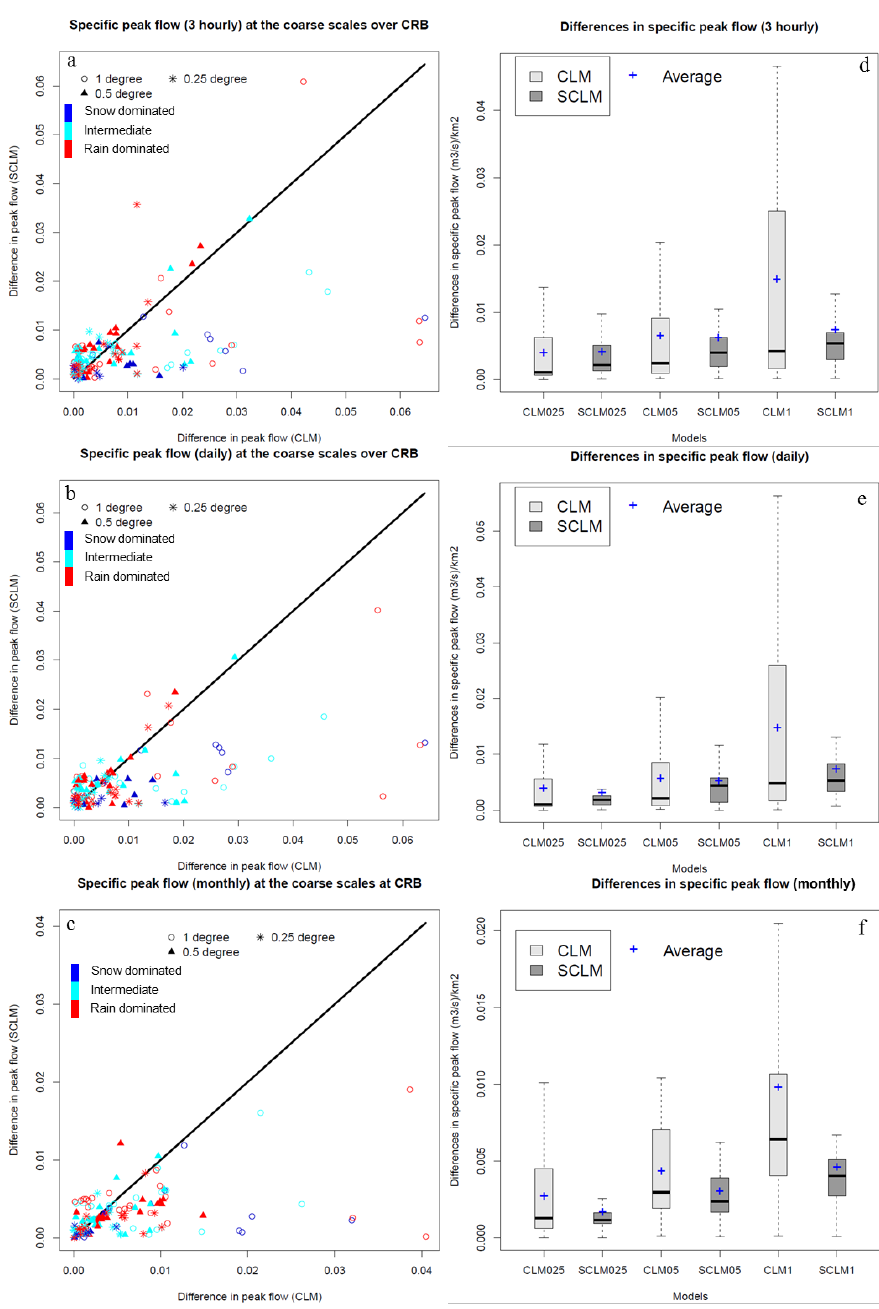
Figure 8. Specific peak flow comparison at 3-hourly, daily and monthly temporal scales at the USGS stations with contributing area larger than 15000km 2 : (a) , (b) and (c) comparison over the climate regions and (d) , (e) and (f) comparing their